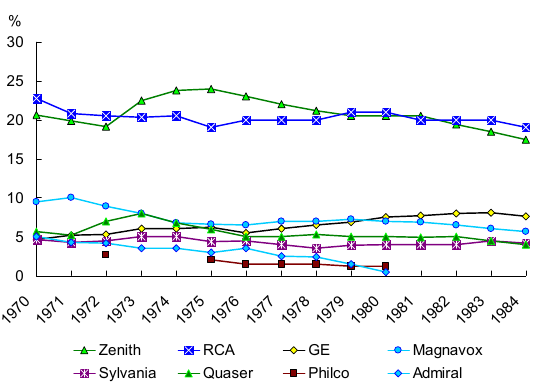
Figure 5. Color TV Market Share in